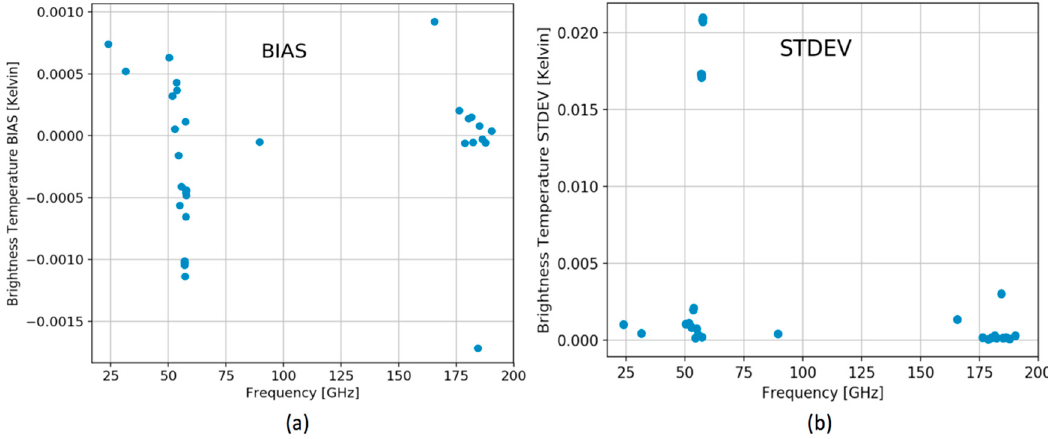
Figure 4. Comparison of fast and line mode of the EIPS framework radiative transfer model, the HT-FRTC: ( a ) Brightness temperature bias (calculated for fast code compared with the line HT-FRTC code). ( b ) Brightness temperature standard deviation between fast and line HT-FRTC code.